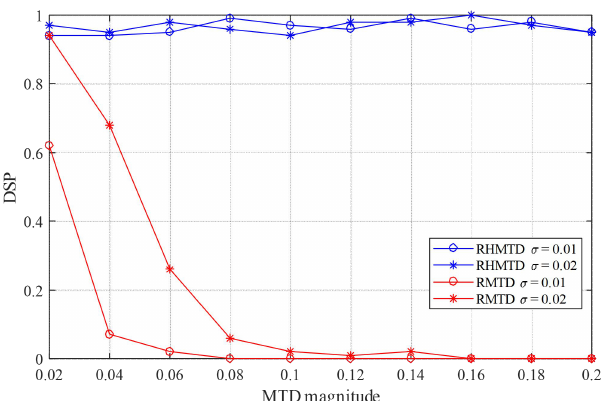
Figure 7. The hiddenness of RMTD and RHMTD against the BDD-based alert attacker under different noise conditions.